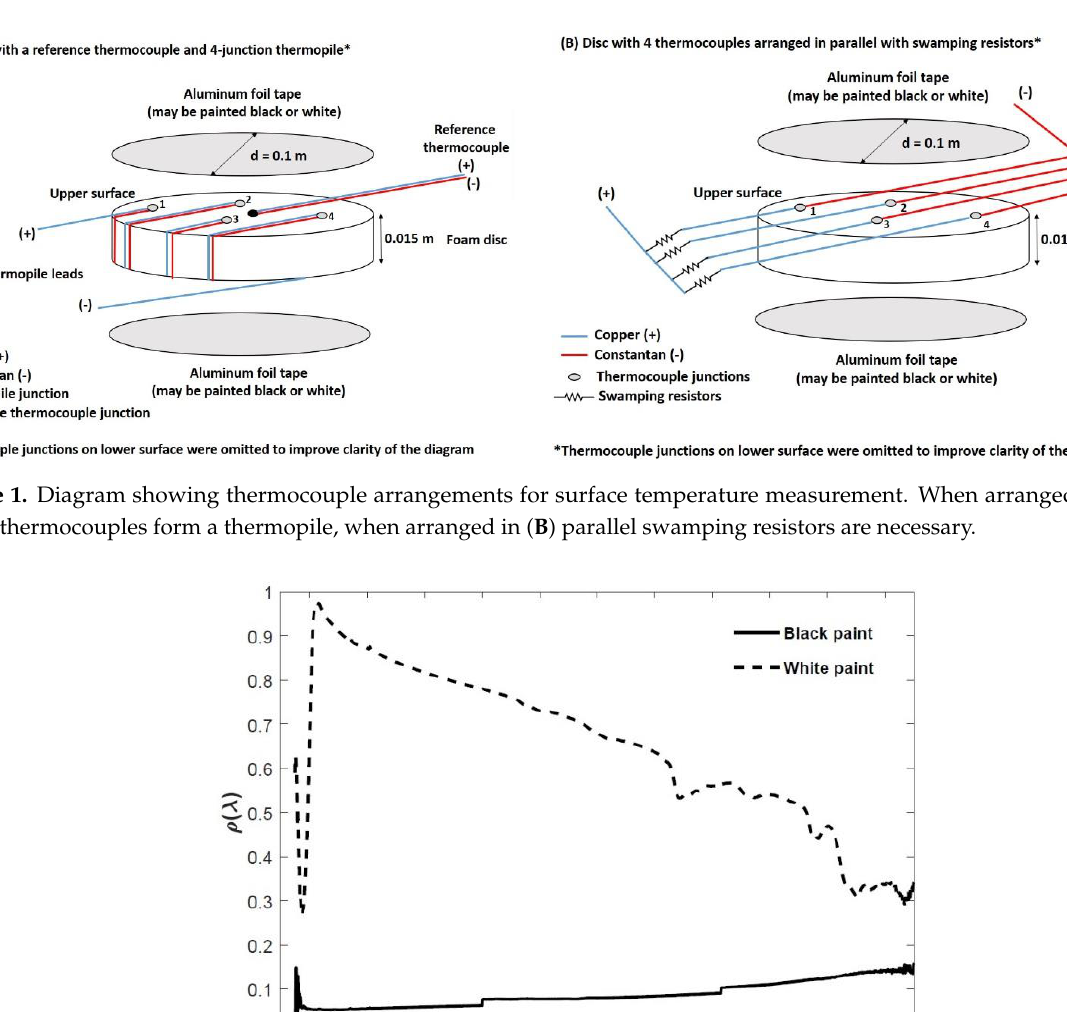
Figure 3. Discs built by students as part of their class project.; ( a ) close-up picture of a disc with its upper surface painted black and ( b ) picture of discs with upper surfaces coated with black and white paint. Discs were set up above a turf grass field for the class activity.